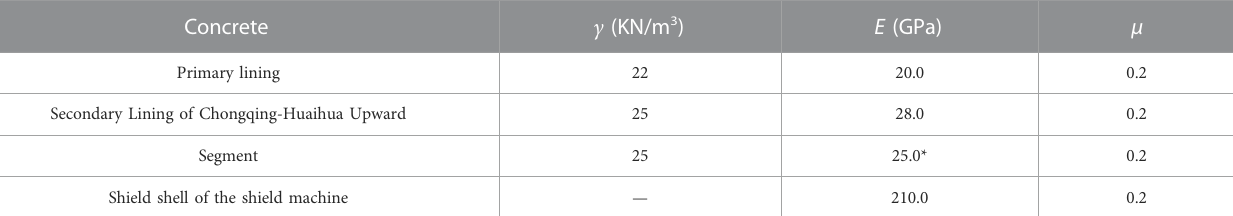
TABLE 5 Mechanical parameters of support materials.